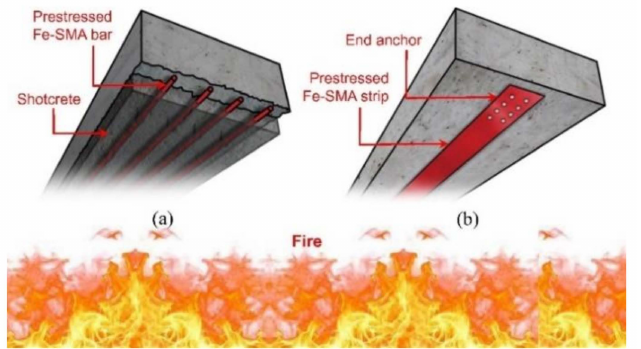
Figure 15. Schematic of prestressed RC structures exposed to fire [110]: ( a ) Fe-SMA bars with shotcrete, and ( b ) Fe-SMA strips with